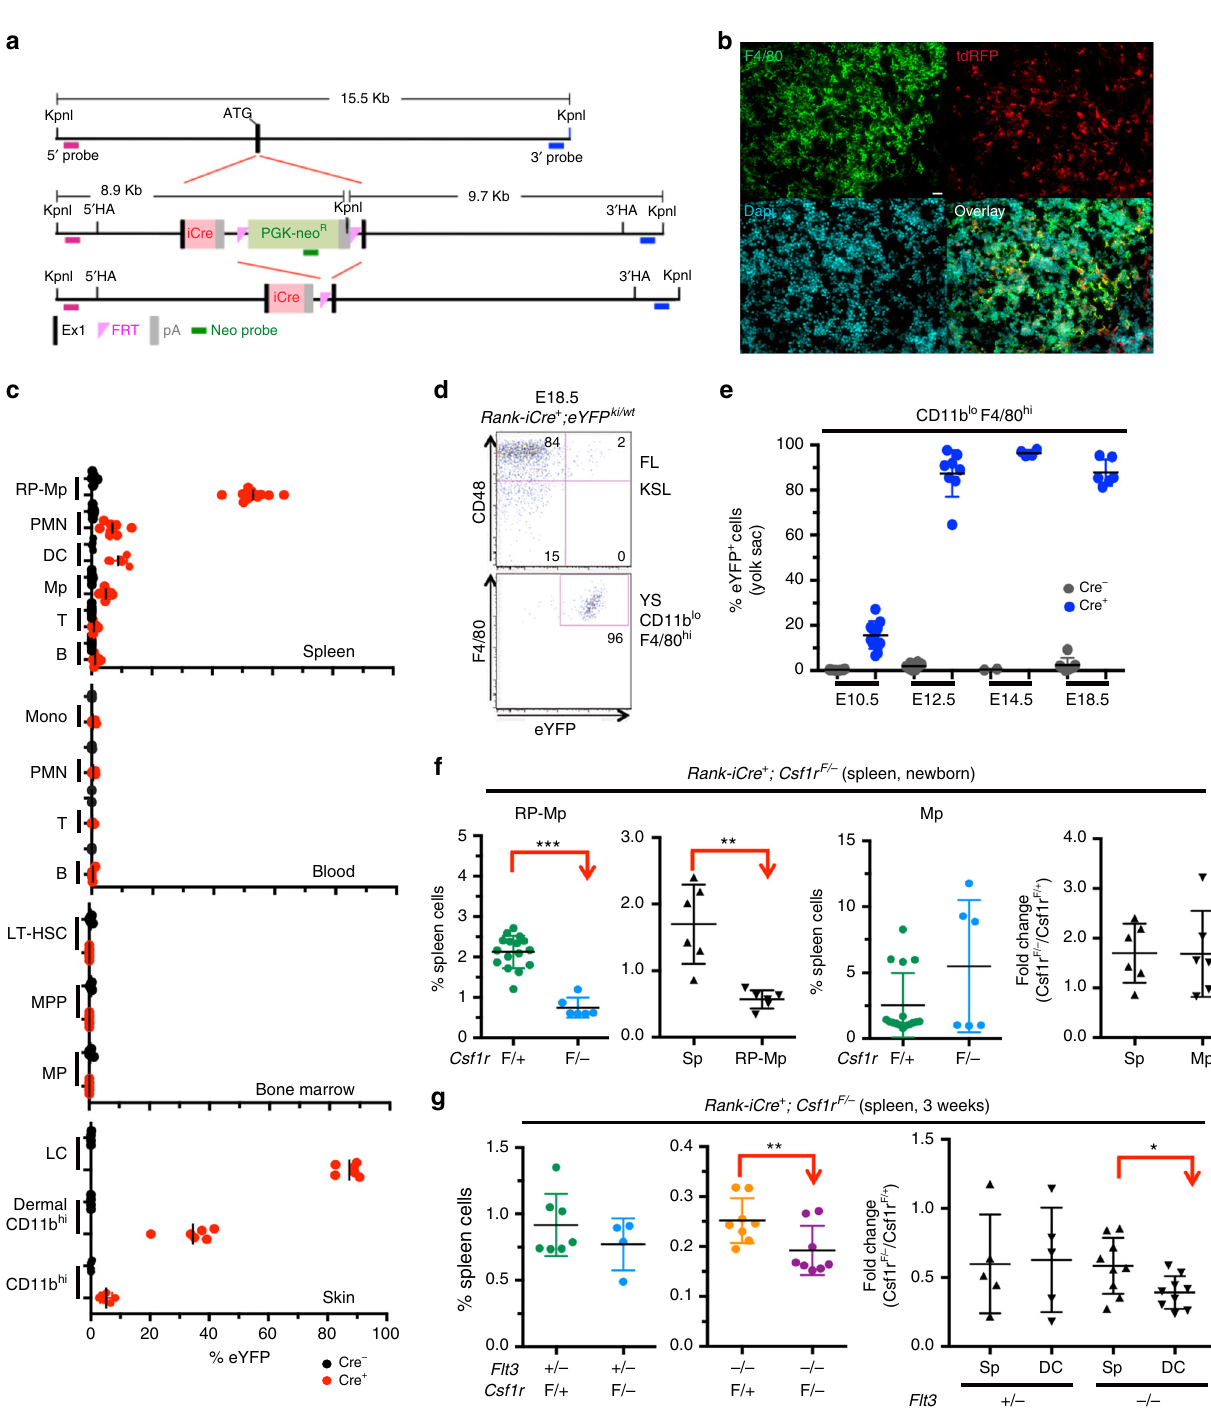
Fig. 4 Tissue-speci fi c depletion of CSF1R in RP-Mps and their progenitors results in loss of DCs. a Scheme of the generation of Rank-iCre mice (iCre = codon-improved Cre). The iCre-recombinase was knocked into exon 1 of the Rank gene. b Immunohistology on spleen sections from 3-week-old Rank-iCre + ;Td-rfp + mice, ×40 objective was used for picture acquisition, scale bar corresponds to 20 μ m. c Lineage tracing of RANK-expressing cells in adult Rank- iCre + ;eYFP ki/wt mice. LT-HSC long-term HSCs, MPP multipotent progenitors, MP myeloid progenitors, LC Langerhans cells. SD is shown. Gatings are shown in Supplementary Fig. 1a and Supplementary Fig. 3b-d. d Dot plots show the labeling of fetal liver Kit + Sca-1 + Lineage − (KSL) hematopoietic stem and progenitor cells (top) and yolk sac CD11b + F4/80 hi macrophages (bottom) from E18.5 Rank-iCre + ;eYFP ki/wt embryos. e Lineage tracing in Rank-iCre; eYFP ki/wt embryos gating on CD11b lo F4/80 hi embryonic macrophages in the yolk sac at the indicated time points. SD is shown. f Plots show the frequencies (left, second right) and fold changes (second left, right) of CD11b lo F4/80 hi RP-Mps or CD11b + F4/80 lo macrophages and spleen leukocytes from newborn Rank-iCre + ;Csf1r F/ − and control mice. Two-sided t test (left and second right) and Mann – Whitney U test (right and second right) were performed. SD is shown. g Plots show frequencies and fold changes of DCs and spleen leukocytes from Rank-iCre + ;Flt3 − / − ;Csf1r F/ − and control mice at 3 weeks of age. Two-sided t test (left) and Mann – Whitney U test (right) were performed. SD is